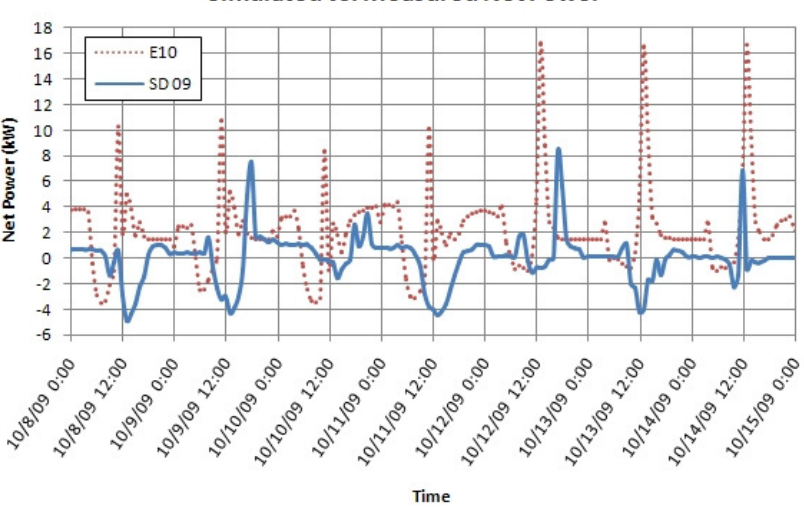
Figure 3. Comparison of AC power usage and generated between the simulated model vs.